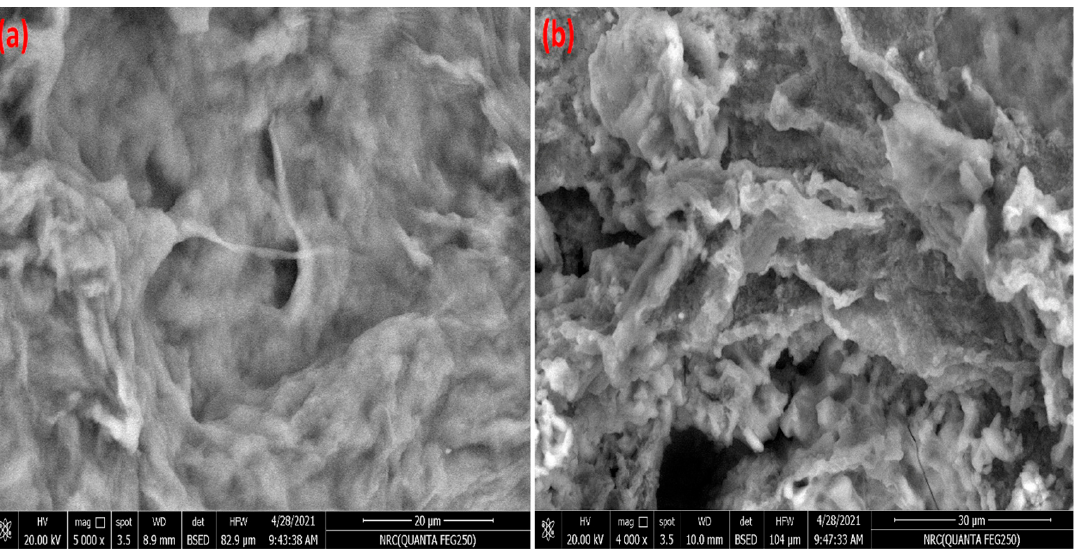
Figure 2. SEM image of C-Cs ( a ) and C-Cs/C-NC ( b